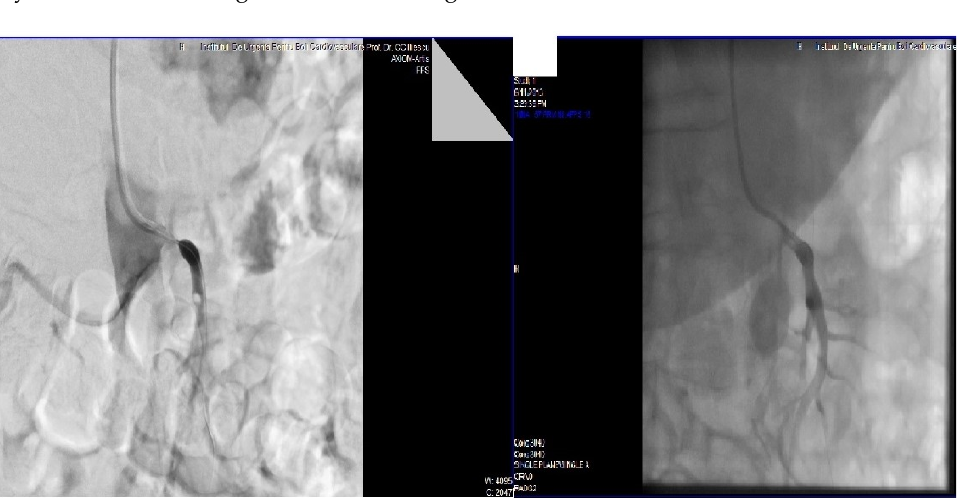
Figure 3. Angiographic image of superior mesenteric artery before ( left ) and after ( right ) stenting. The bone marrow biopsy performed due to a suspicion of ET revealed megakaryocytic hyperplasia. Genetic testing for JAK-2 mutation revealed the presence of the mutation, supporting the diagnosis of ET [20,21].